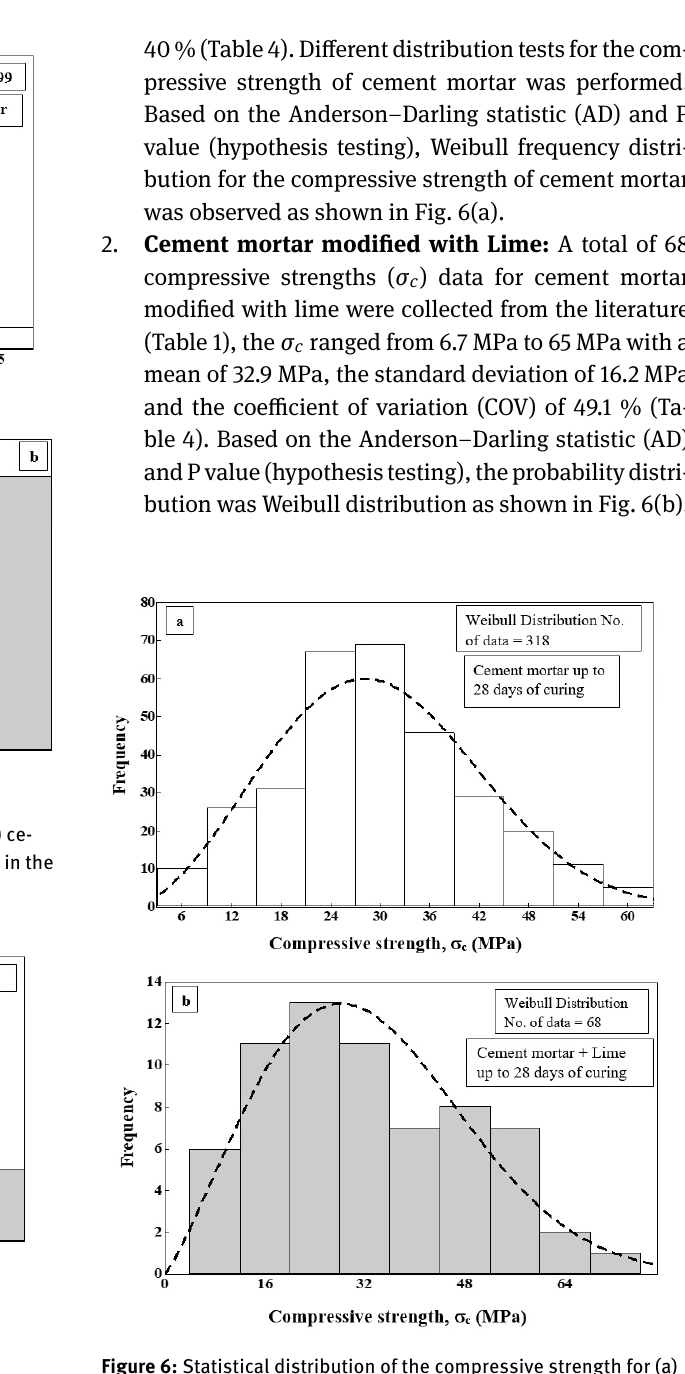
Figure 6: Statistical distribution of the compressive strength for